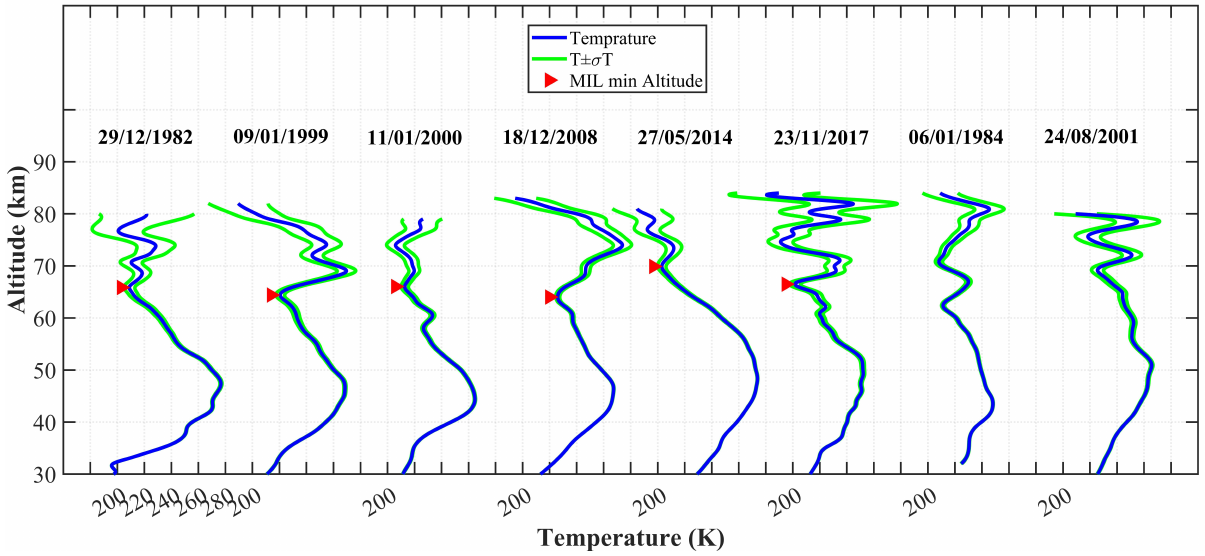
Figure 1. Selected examples of vertical temperature profiles from the OHP lidar since 1982. Perturba- tions, potentially identified as MILs, appear at different levels and altitudes of the bottom part of the MIL are indicated with an arrow. According to noise and gravity wave mean amplitude, 2 cases were rejected as significative MILs: 6 January 1984 and 24 August